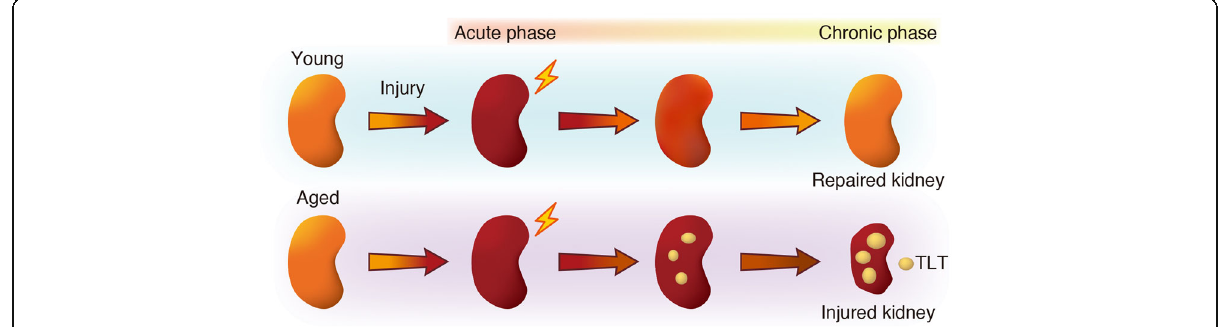
Fig. 2 The distinct injury response in young and aged mice. Aged mice, but not young mice, developed multiple tertiary lymphoid tissues (TLTs) in the kidney after acute kidney injury (AKI). TLTs sustain and amplify inflammation and retard regeneration, resulting a poor renal outcome in aged